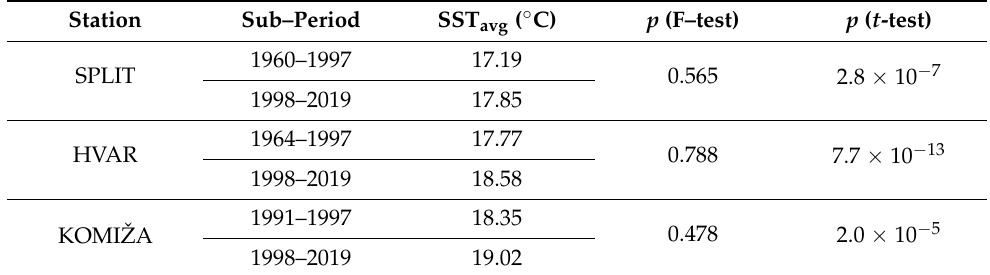
Figure 3. Time series of the mean annual SST measured at Split, Hvar, and Komiža stations. SST avg is an average value of the mean annual SST, and p represents M–K test values, calculated for two sub–periods defined by the results of Rescaled Adjusted Partial Sums (RAPS) method. Table 3. The average values of the mean annual SST time series within a sub–period defined by the RAPS method at the analyzed stations and the results of the F–test and the t–test.